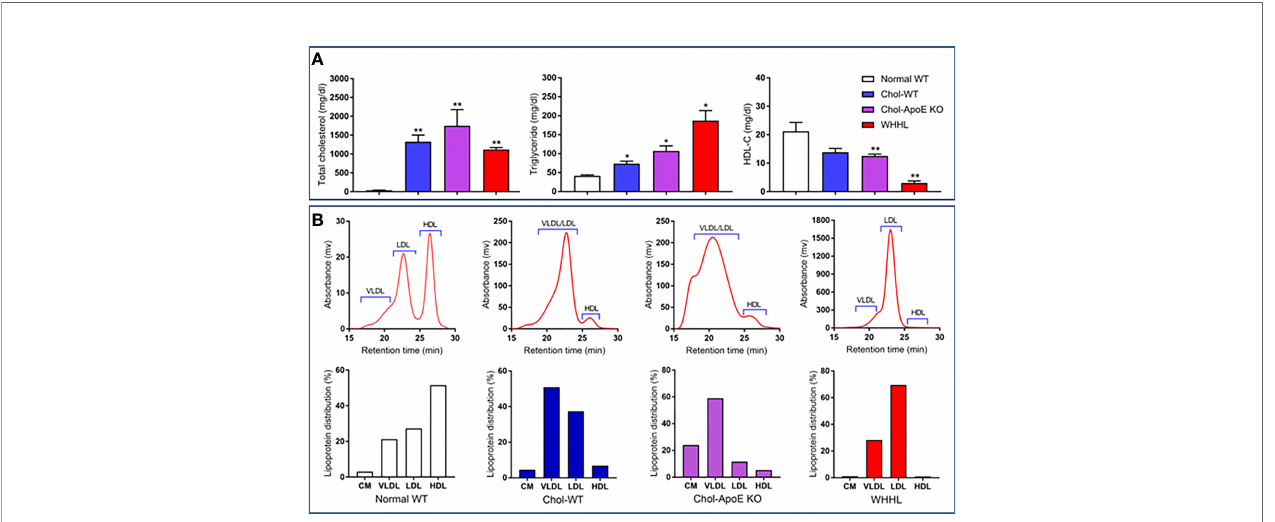
FIGURE 1 | Plasma lipids (A) and lipoprotein pro fi les (B) . Plasma lipids including total cholesterol (TC), triglycerides (TG), and high-density lipoprotein cholesterol (HDL-C) were measured in different rabbits fasted overnight. All animals were males and n=6 for each group and the data are expressed as the mean ± SEM.